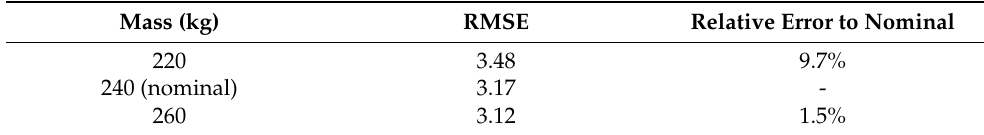
Figure 14. Experimental results of tire stiffness estimation with respect to different sprung mass; ( a ) response of time-varying tire stiffness, ( b ) time evolution of the forgetting factor, ( c ) estimation error and ( d ) convergence history of the error covariance (inset: detail A, around pressure change). Table 4. Comparison of RMSE for different sprung